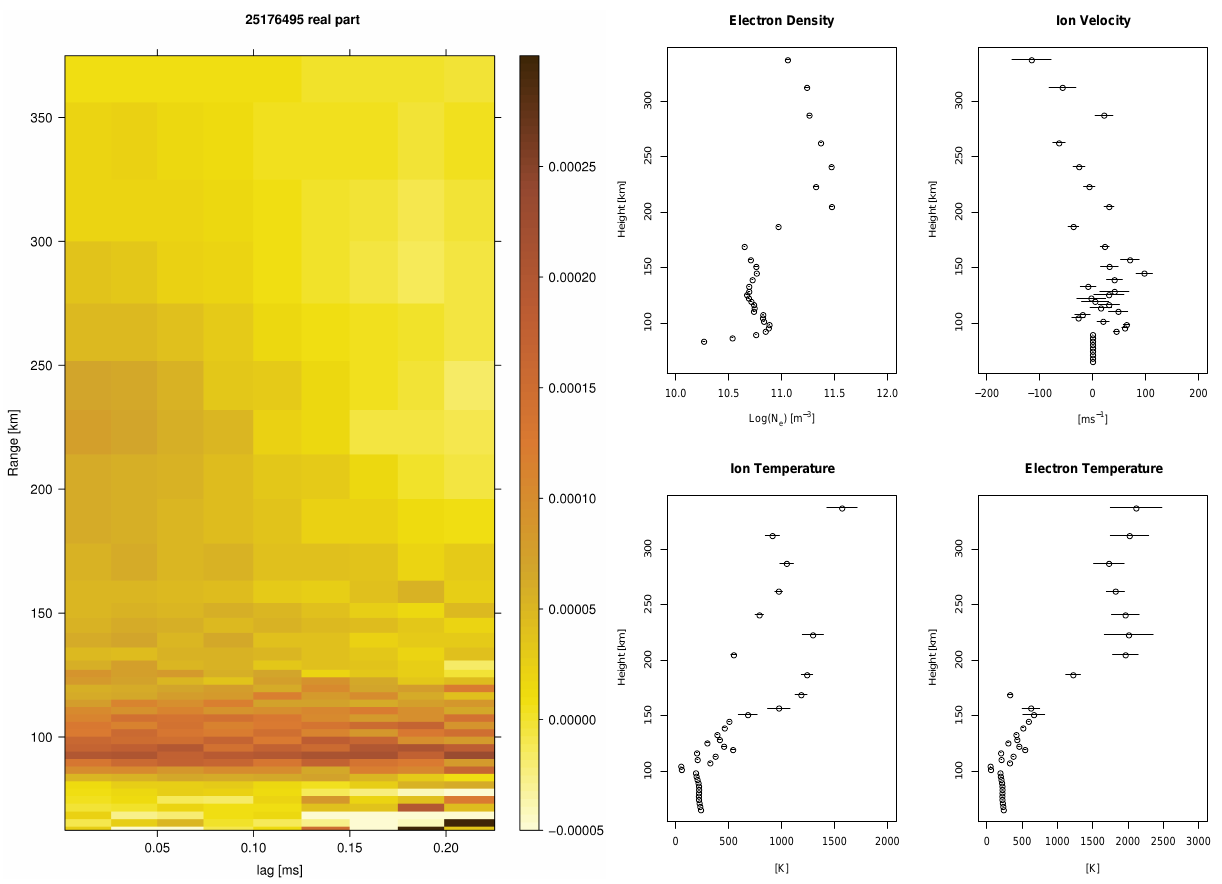
Fig. 7. Analysis results of experiment 2 from 19 October 2007 09:28UT. Left panel: Real part of ACF in arbitrary units. Time resolution is 5s and range resolution varies from 3km in D- and lower E-regions to 50km above F-region peak. Right panel: Plasma parameters with 1min time resolution. The horisontal lines are 68% confidence intervals. Model values are used for ion mass and collision frequency at all altitudes, for ion temperature below 100km, for electron to ion temperature ratio below 150km and ion velocity is set to zero below 90km. Due to insufficiently short pulses of the experiment the fit results for temperatures may not be reliable. Electron density is not calibrated.